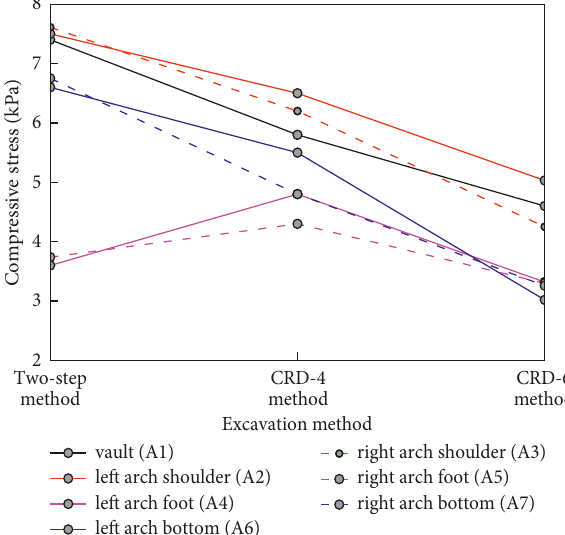
Figure 7: Final surrounding rock stress under different excavation methods without pre-reinforcement.